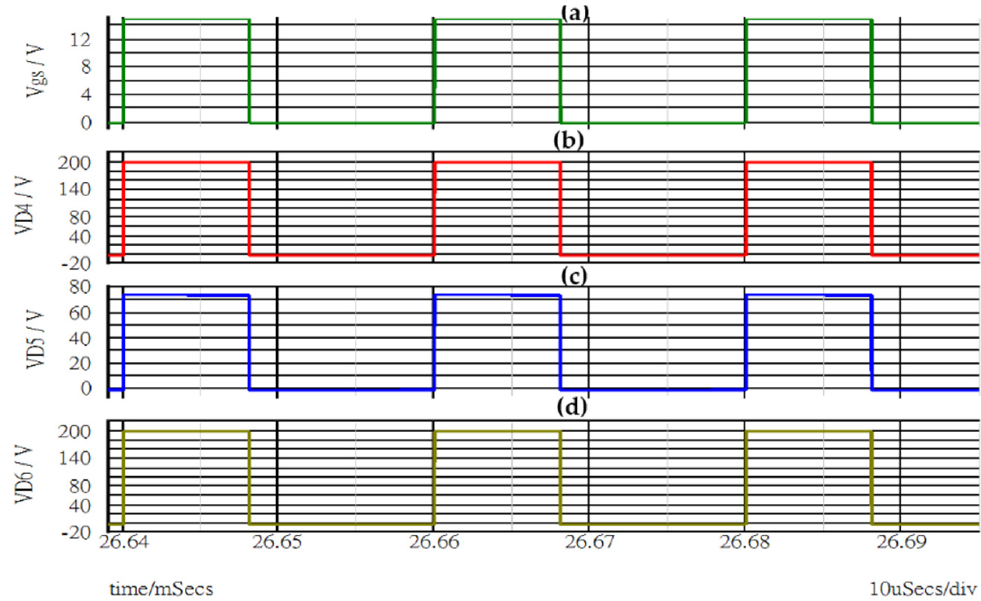
Figure 15. Simulated waveform of ( a ) duty cycle ( V gs ) at duty d = 0.402, ( b ) Voltage stress of diode